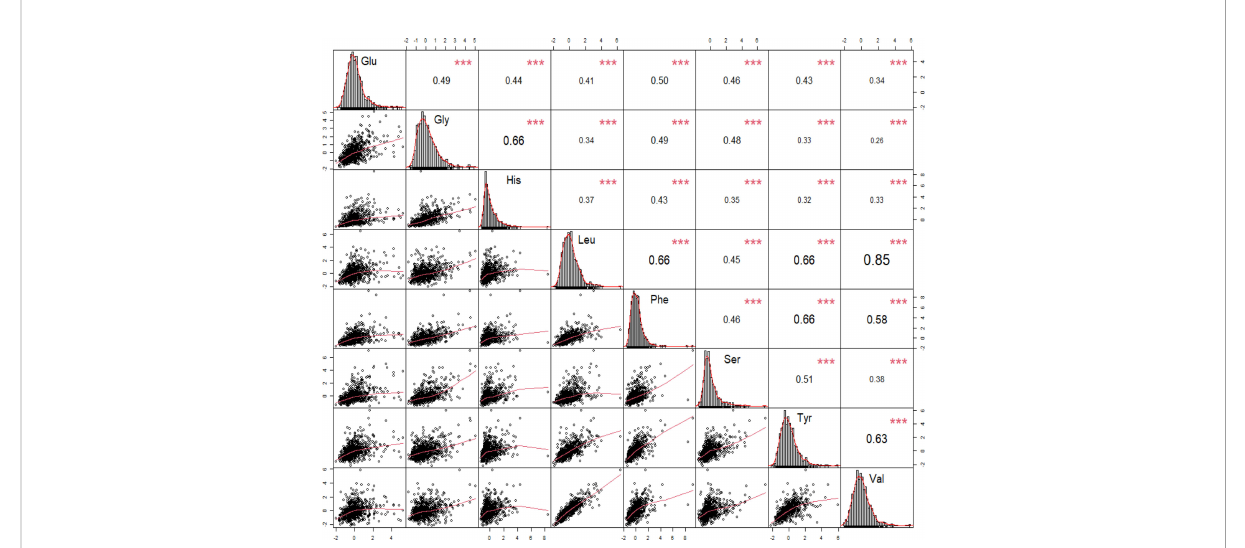
FIGURE 3 Correlations between signi fi cant amino acids for the pathogenesis of diabetic retinopathy. Leu, leucine; Phe, phenylalanine; Tyr, tyrosine; Val, valine; Gly, glycine; His, histidine; Ser, serine; Glu, glutamate. * p-value < 0.05, ** p-value < 0.01, ***p-value < 0.001.